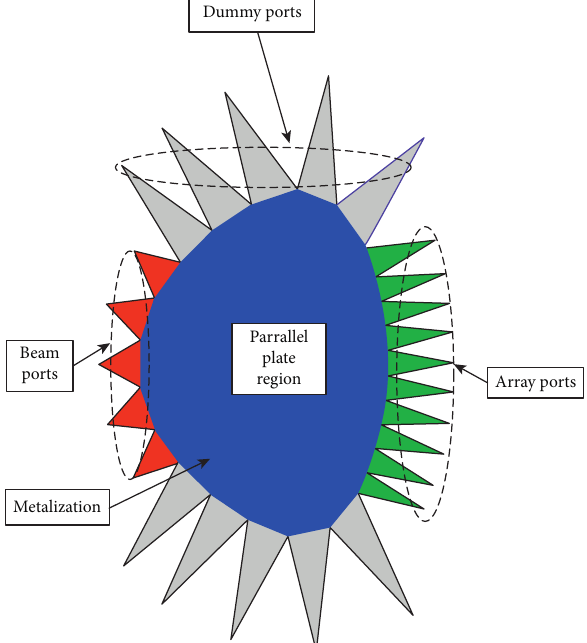
Figure 1: Rotman lens